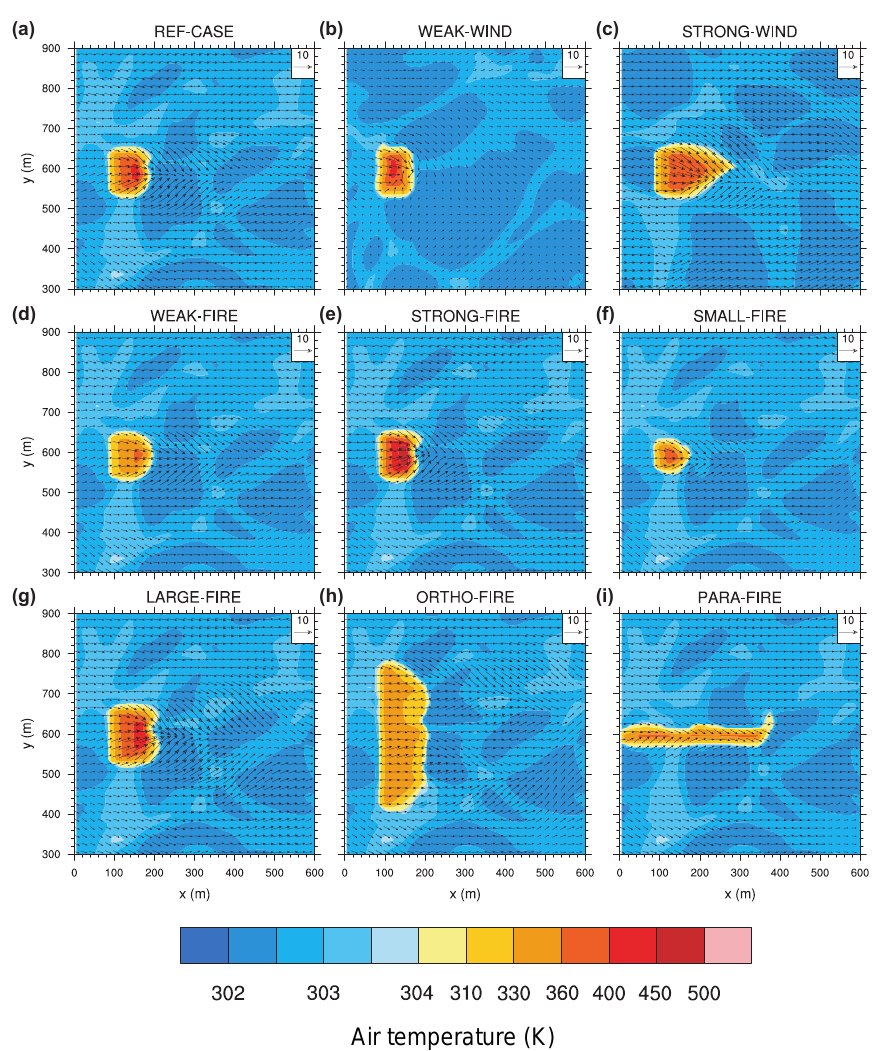
Figure 4. Horizontal cross sections of the wind vector and air temperature fields 20min after fire ignition in the lowest model level of z =